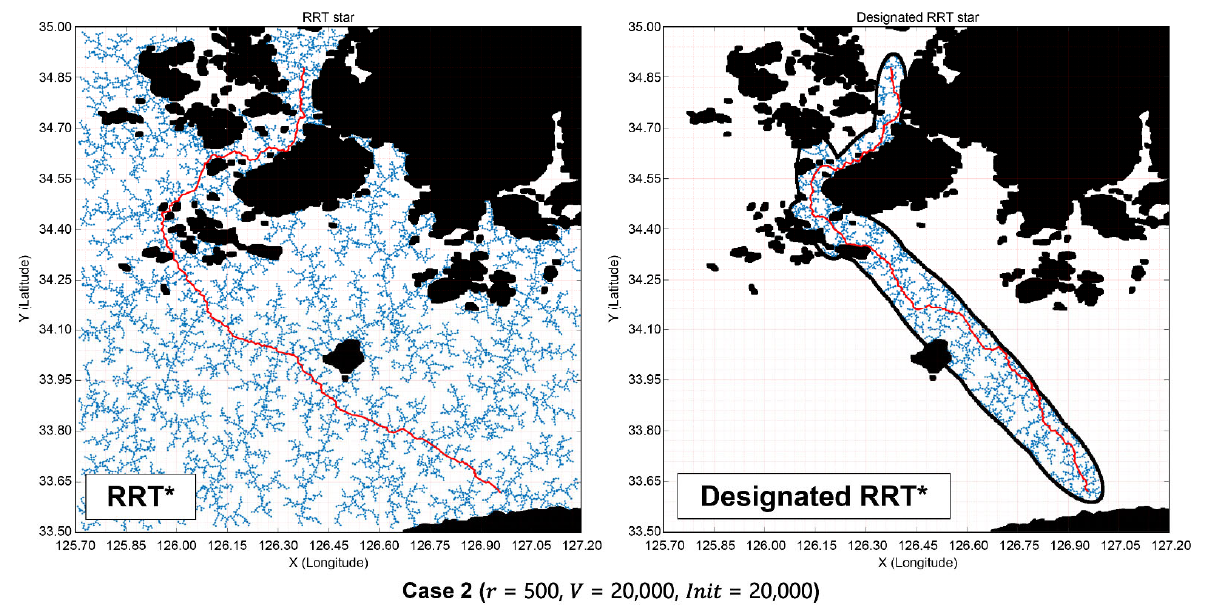
Figure 21. Comparison of the simulation results (Case 1).